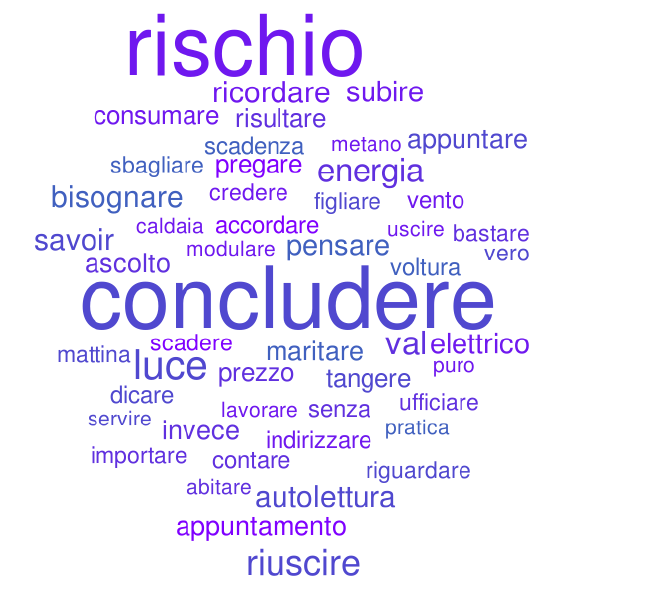
Figure 13. World Cloud of topic 19.